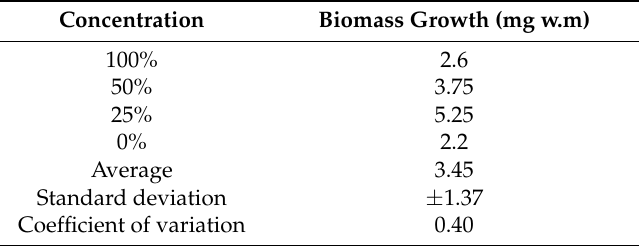
Table 3. Biomass growth of E. densa in systems with different wastewater concentration (0, 25, 50,